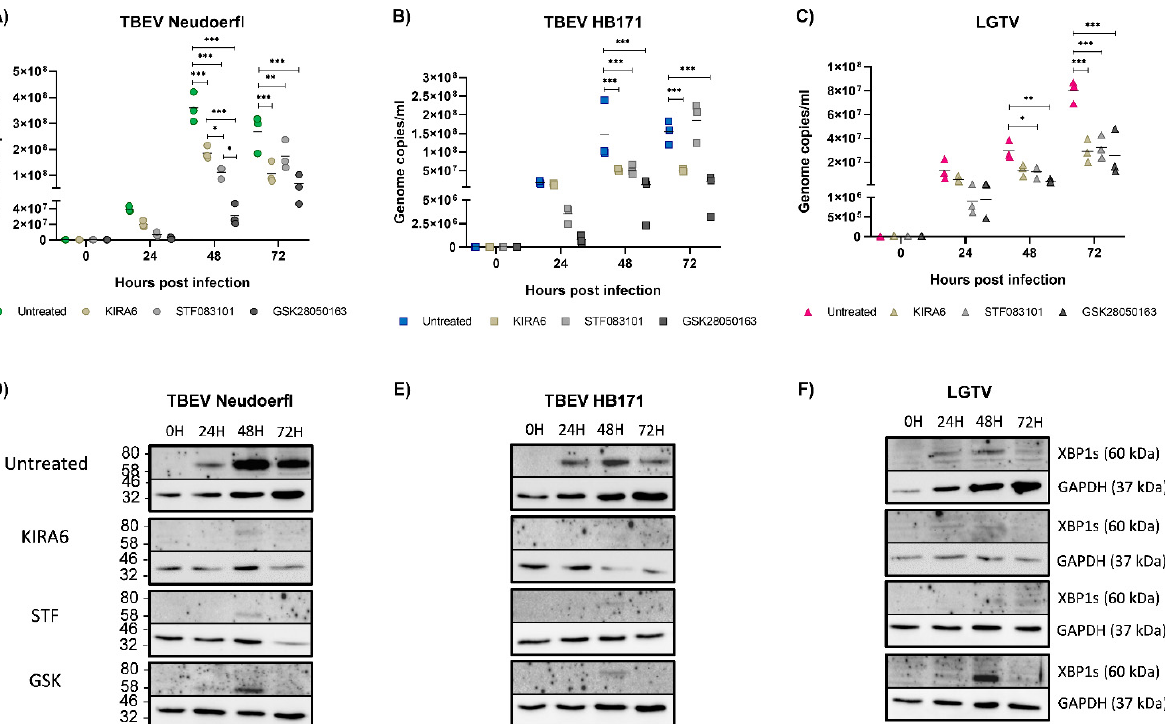
Figure 4. Infection experiments with the neuronal cell line SH-SY5Y were repeated as described in Figure 1, but cells were pretreated with IRE1 inhibitors KIRA6 (KIRA), STF083010 (STF) and GSK2850163 (GSK) for four hours prior to infection as well as after infection or left untreated. Viral RNA was extracted from culture supernatants and cell lysates were collected at 0, 24, 48 and 72 h post infection. Infections of untreated cells with Neudoerfl are shown in green ( A ), HB171 in blue ( B ) and LGTV in pink ( C ). Infections of cells pretreated with KIRA are shown in light brown, STF in light grey and GSK in dark grey, respectively. All infections were performed in triplicates and repeated three times. Statistical analyses were performed by 2-way ANOVA with Tukey’s multiple comparison test, ** p < 0.002, *** p < 0.001. Cell lysates were analyzed by Western blot for XBP1 expression after infection with Neudoerfl ( D ), HB171 ( E ) or LGTV ( F ). GAPDH expression was analyzed as a housekeeping control. A representative blot is shown. kDa, kilodalton.